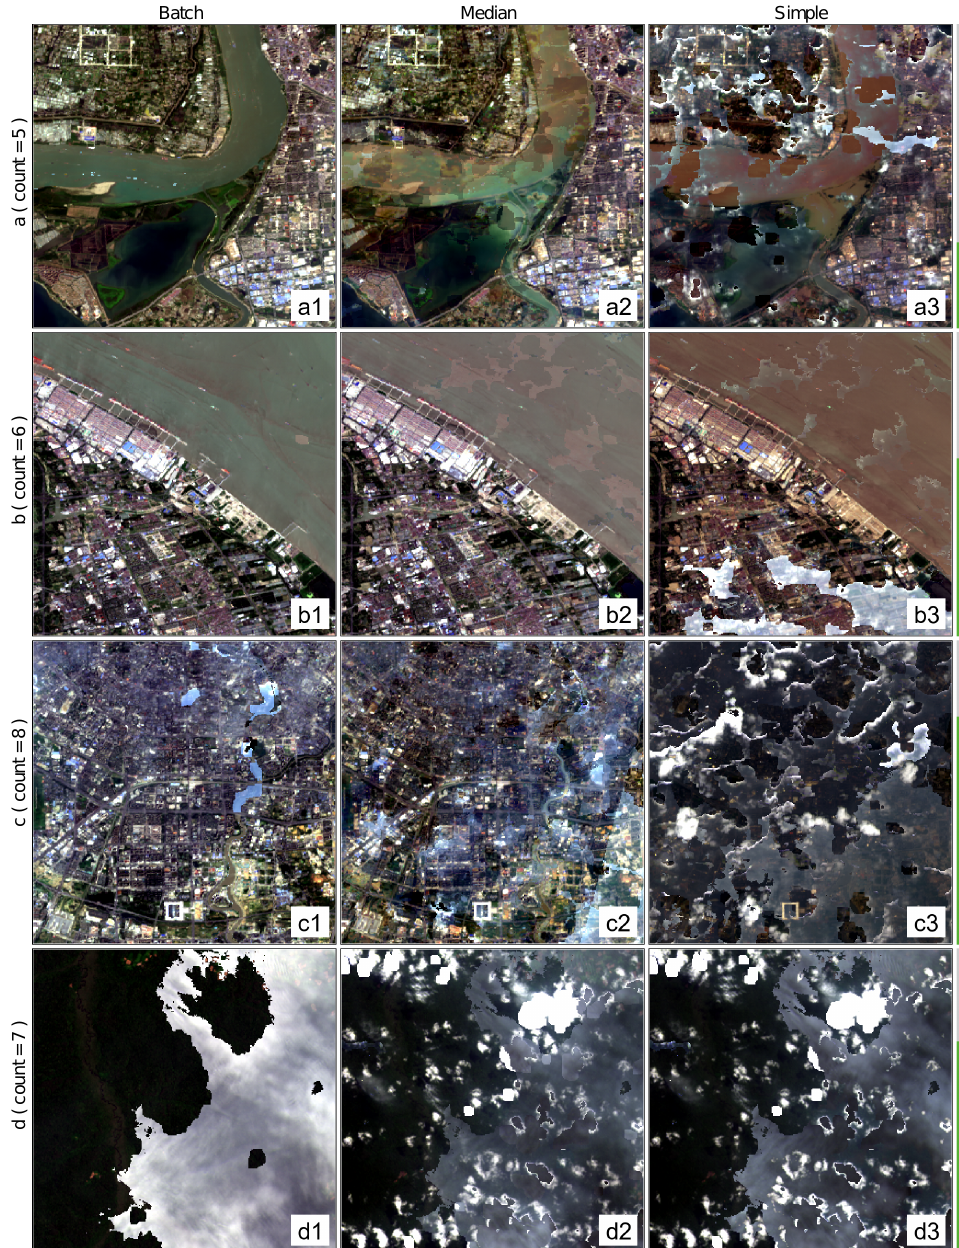
Figure 8. Visual comparison part 1: Band 4/3/2 composition produced by different algorithms at locations from ( a – d ). Each location discloses the number of available image scenes (count variable from the left edge) and the average cloud coverage. The latter is represented by the vertical progress bar (max is 100%) on the right edge; ( a1 , b1 , c1 , d1 ) are produced with the batch algorithm, ( a2 , b2 , c2 , d2 ) are produced with the median algorithm, and ( a3 , b3 , c3 , d3 ) are produced with the simple